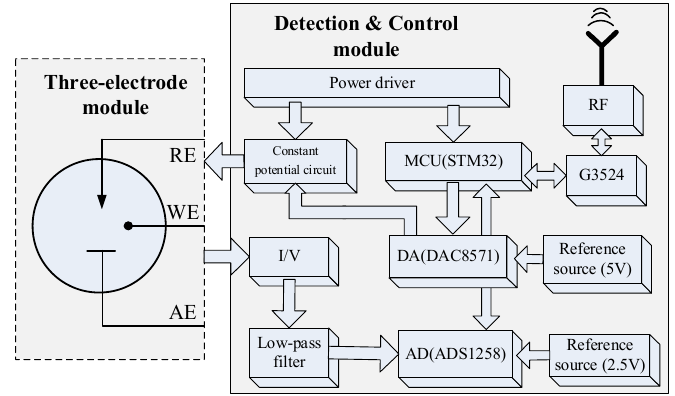
Figure 3. Measurement system structure schematic.